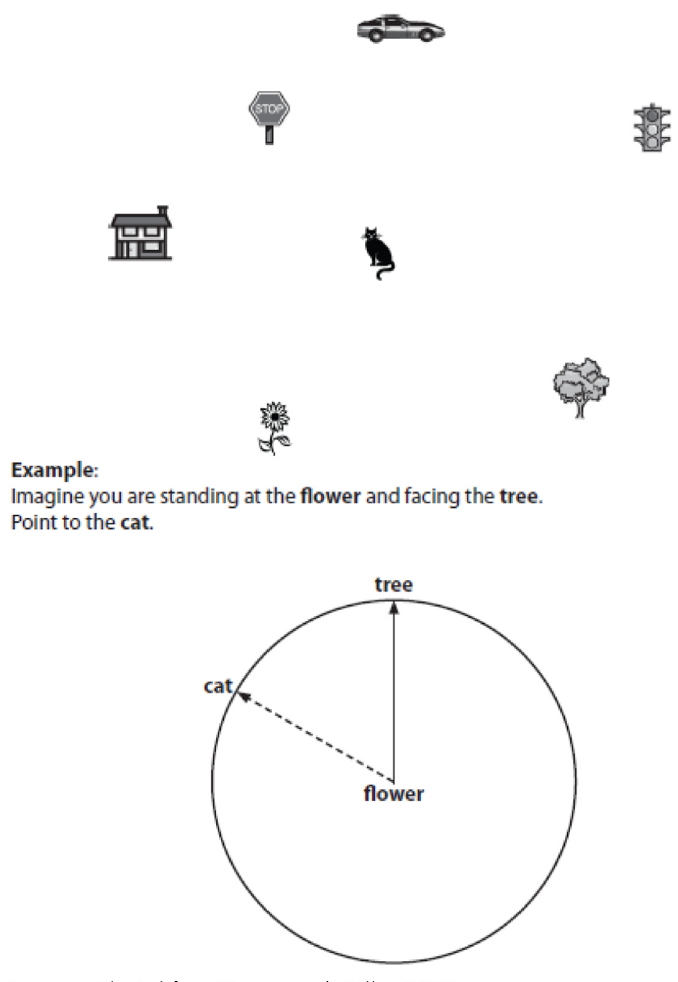
Figure 5. A common task on spatial